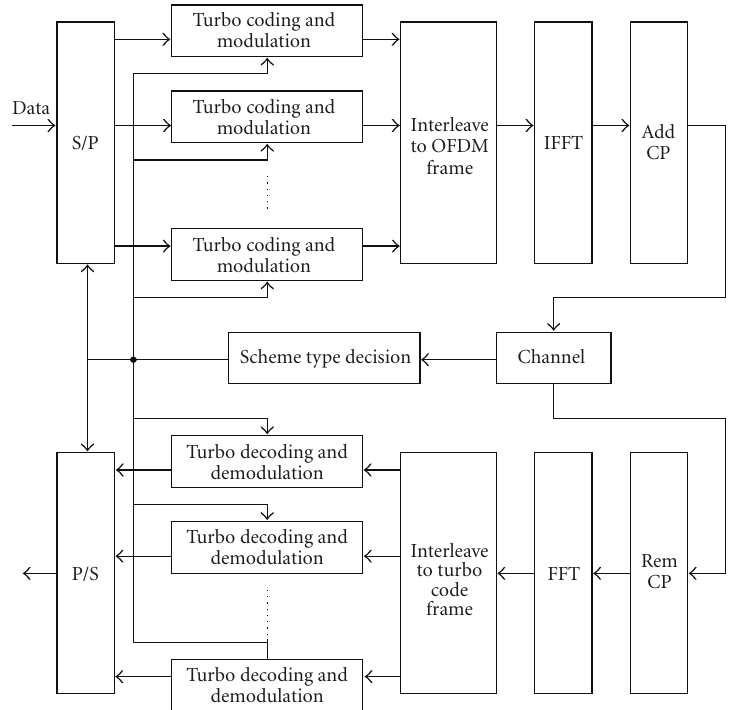
Figure 1: System structure of separate turbo code adaptive